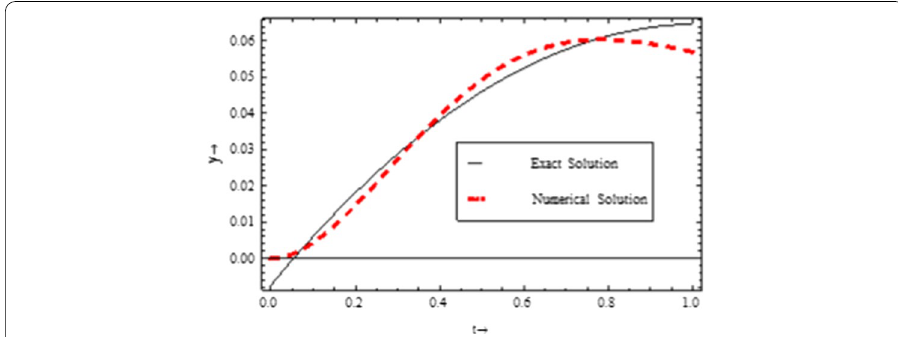
Fig. 3 The exact and the approximate solution of Eq. (26) for m =